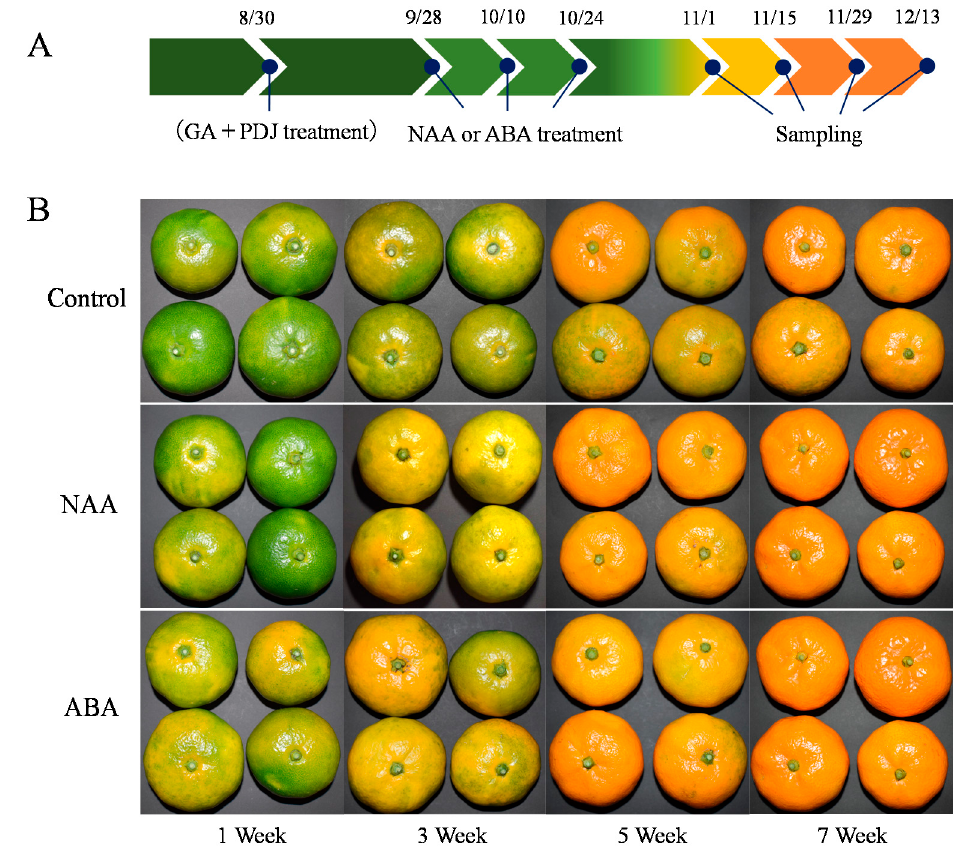
Figure 2. Effect of NAA and ABA on the appearance of gibberellin (GA) and prohydrojasmon (PDJ)-treated citrus fruit. ( A ) the treatment schedule; ( B ) the changes of the color in the peel. Fruit treated with GA and PDJ was used as control.